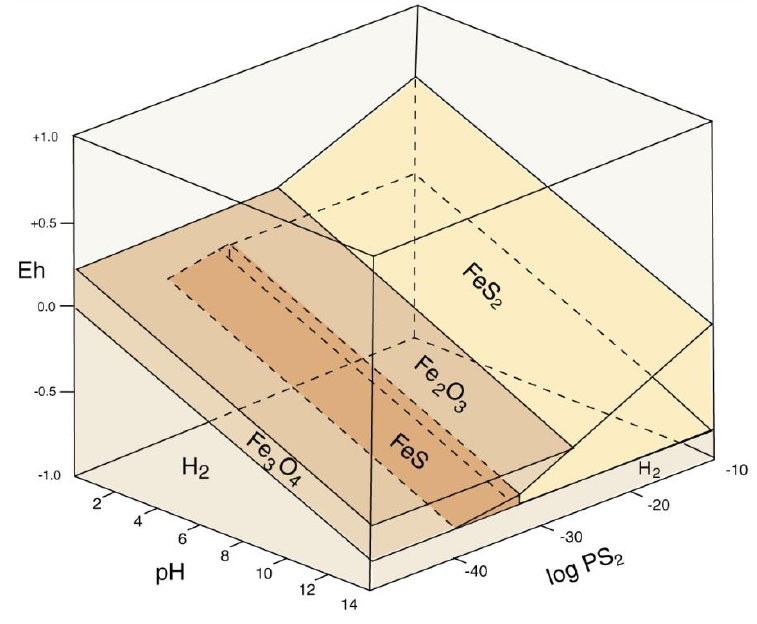
Figure 34. Phase diagram for common iron sulfide and oxide minerals. Reprinted from [38].